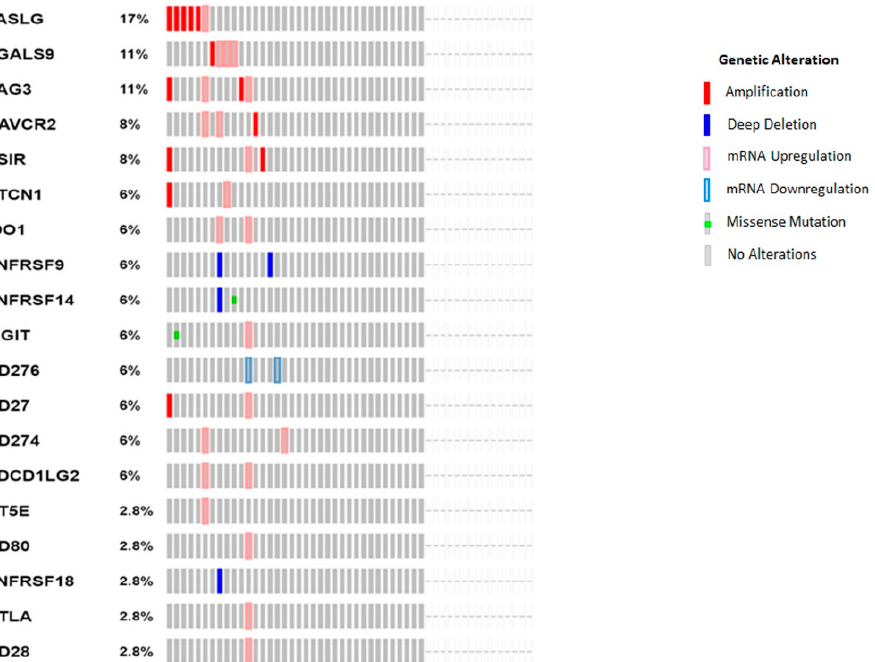
Figure 1. The OncoPrint analyses of CCA patients reveal changes in expression of ICs. Rows and columns represent genes and CCA patients, respectively. Genetic alterations, such as copy number alterations (homozygous deletions and amplifications), mutations and gene expression changes, are represented by glyphs and color codes. The patient order is presented as per alterations.